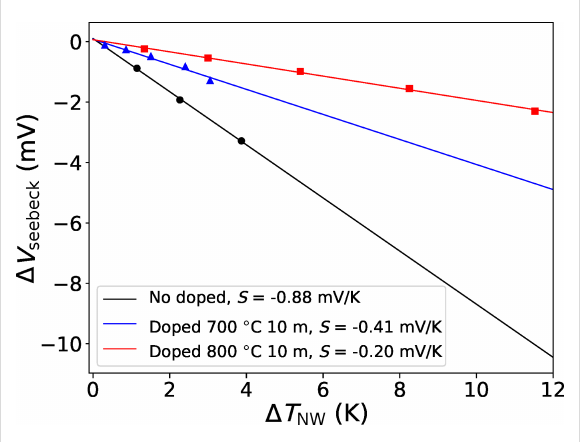
Figure 3: Measured voltage drop (Seebeck voltage Δ V seebeck ) as a function of the temperature difference between the ends of the nano- wires, Δ T NW . The slope is the Seebeck coefficient of the